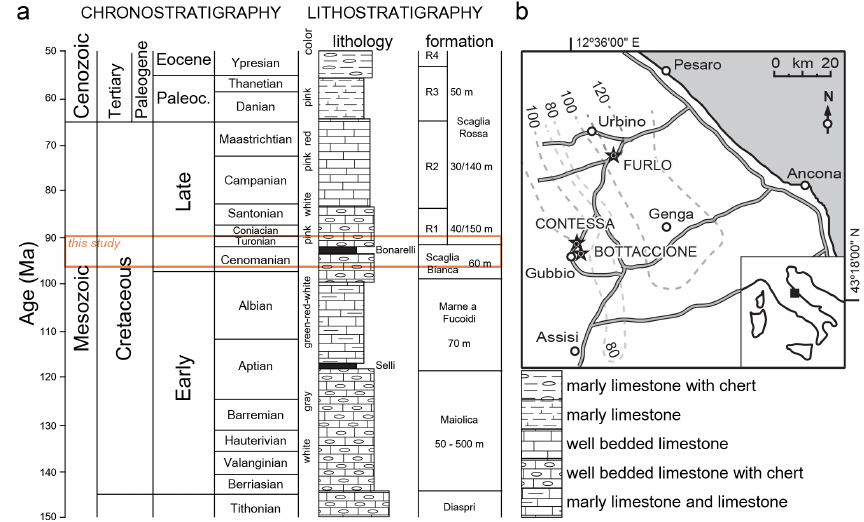
Figure 1. (a) Chrono- and lithostratigraphy of the Umbria–Marche succession in the Apennine mountains (adapted from Alvarez et al., 2011). (b) Geographic setting of the study sections with isopachs of the Bonarelli level (in cm) from Montanari et al.